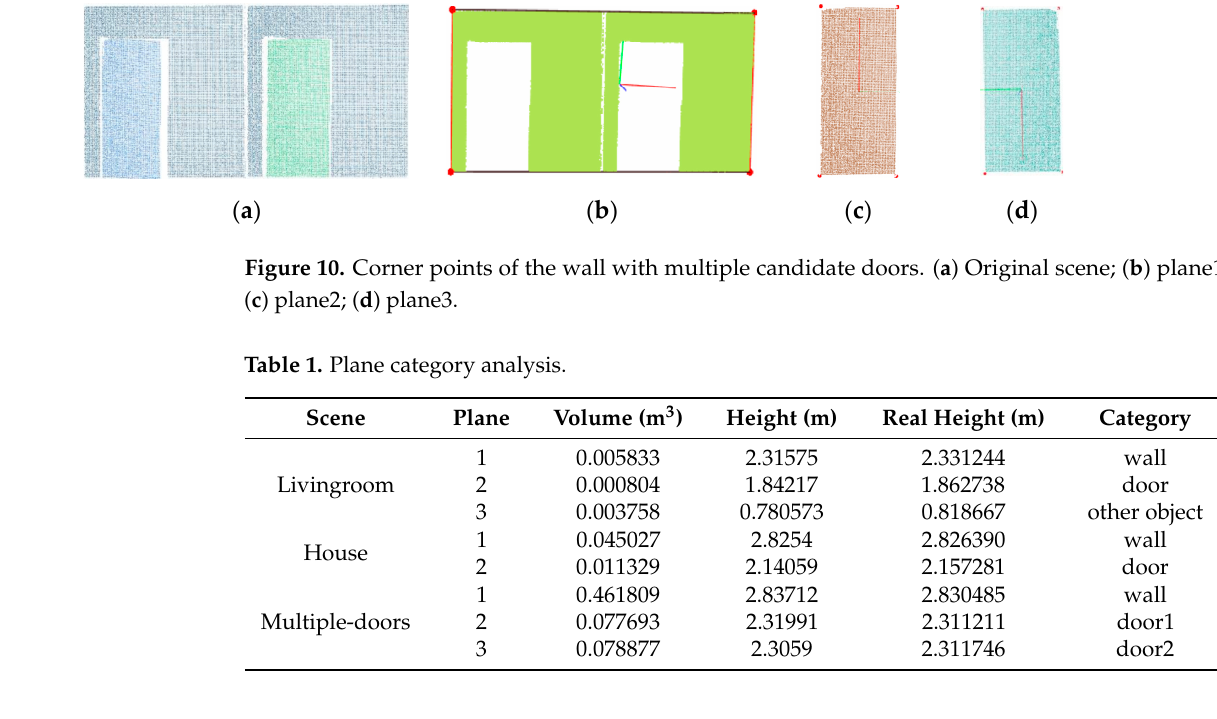
Table 2. The angle of the straight line and the state of the door. Figure 10. Corner points of the wall with multiple candidate doors. ( a ) Original scene; ( b ) plane1; ( c ) plane2; ( d ) plane3